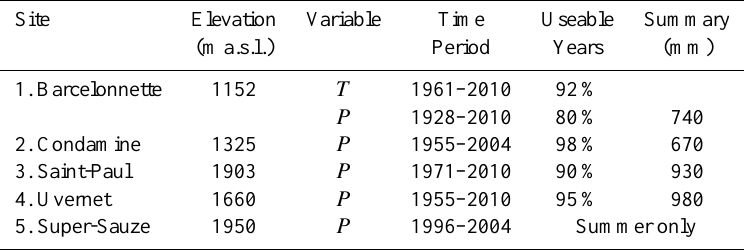
Table 1. Weather station information for the Ubaye Valley. The numbers refer to those in Fig. 1. The usable years show the percentage of years that are homogeneous and have at least 99% of days where the gauge was working. T =temperature, P =precipitation. The final column is the mean annual total precipitation, where applicable.